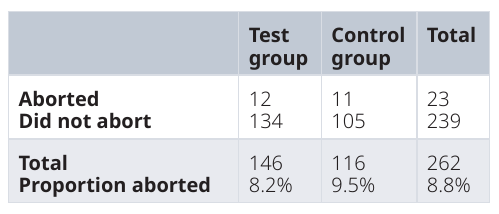
Table 5. Abortion rates for cattle.